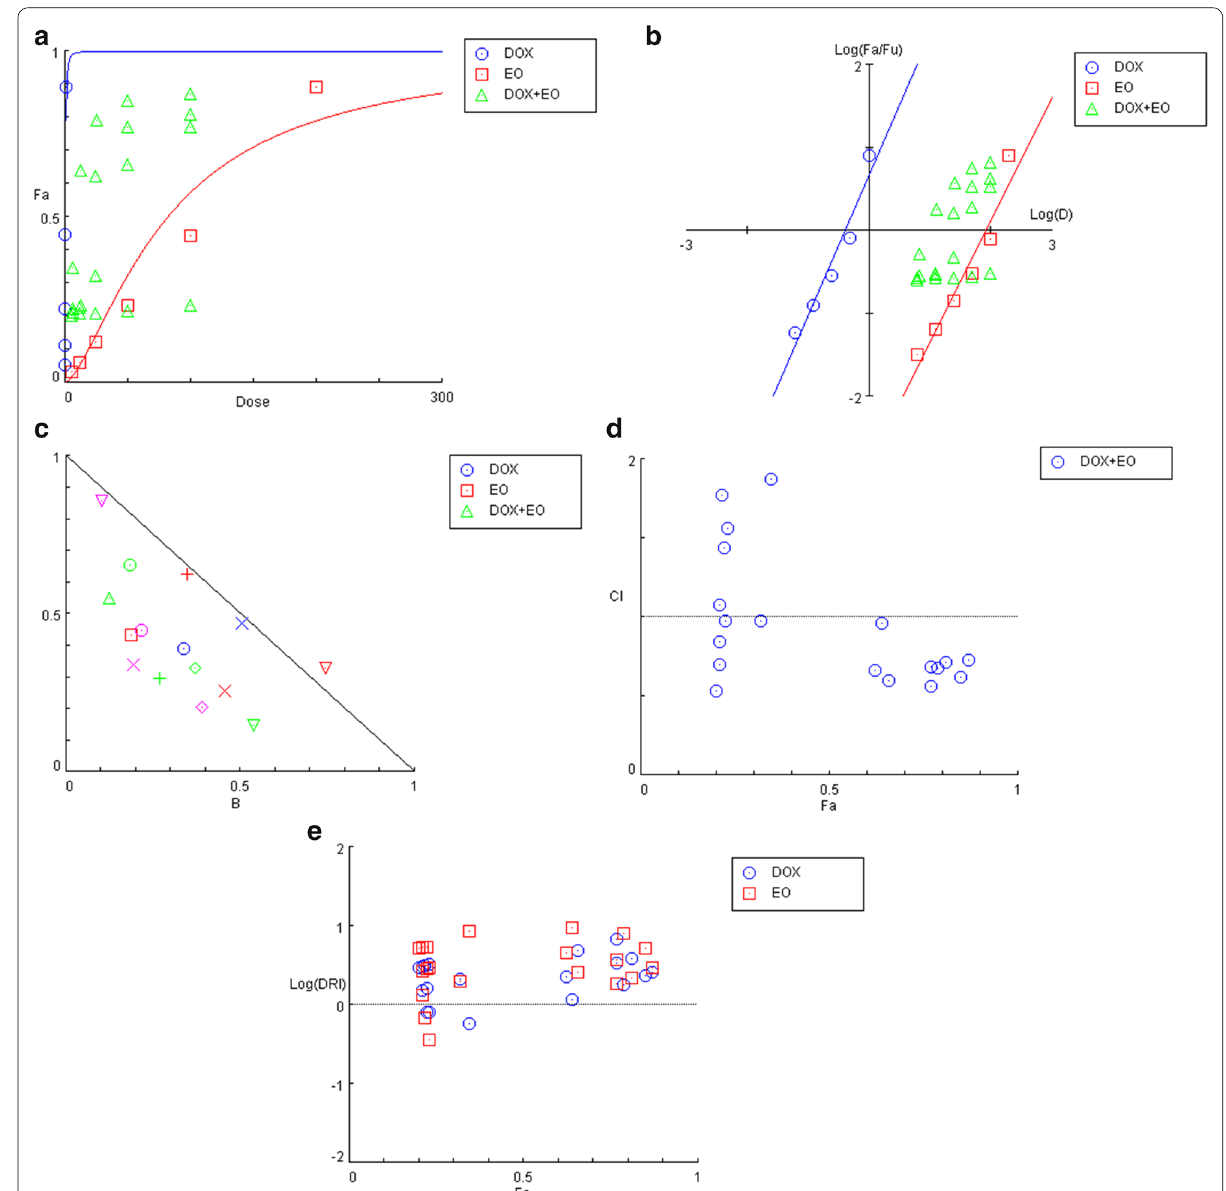
Fig. 3 Evaluation of the synergism of doxycycline in combination with essential oil (EO) of A. conyzoides . Data sets in blue, red and green correspond to doxycycline, EO, combinations, respectively. a Dose–response curves of each individual treatment. Doxycycline was evaluated twice, for each of the combinations with EO. The antibacterial effect was determined by measurement of foci size. b Median-effect representation of the dose–response curves for each individual compound, using Eq. (3). fa is the “fraction affected”, or (% effect) 100. c Normalised isobologram that ÷ represents, for each combination, the normalised dose of each treatment individually required to reach the observed effect in combination (Eq. 2). d CI-effect plot representing the combination index CI, calculated using Eq. (1), of each combination as a function of their associated antibacterial effect. e Log (DRI)-effect plot representing the drug reduction index (DRI) of compounds as a function of their antibacterial effect in combination. The DRI is calculated for each drug in each combination according to Eq. (4) and represents the dilution factor required for a drug to reach the same level of inhibition individually compared with it when in combination. The results are representative of 3 independent